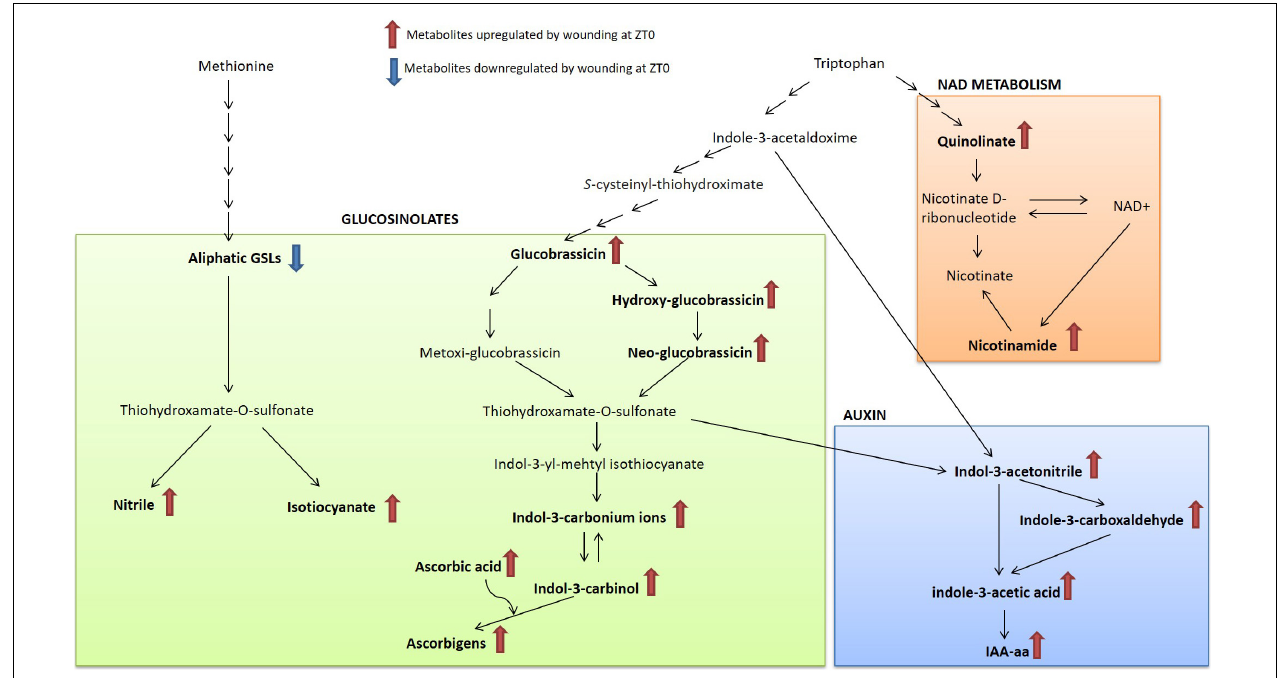
FIGURE 5 | Schematic representation of the major metabolic pathways activated in response to wounding in broccoli ( B. oleracea var. botrytis ). Metabolites in bold show a significant variation after wounding treatment. NAD, nicotinamide adenine dinucleotide; IAA-aa, Indole-3-acetic acid conjugated by amide linkage to amino